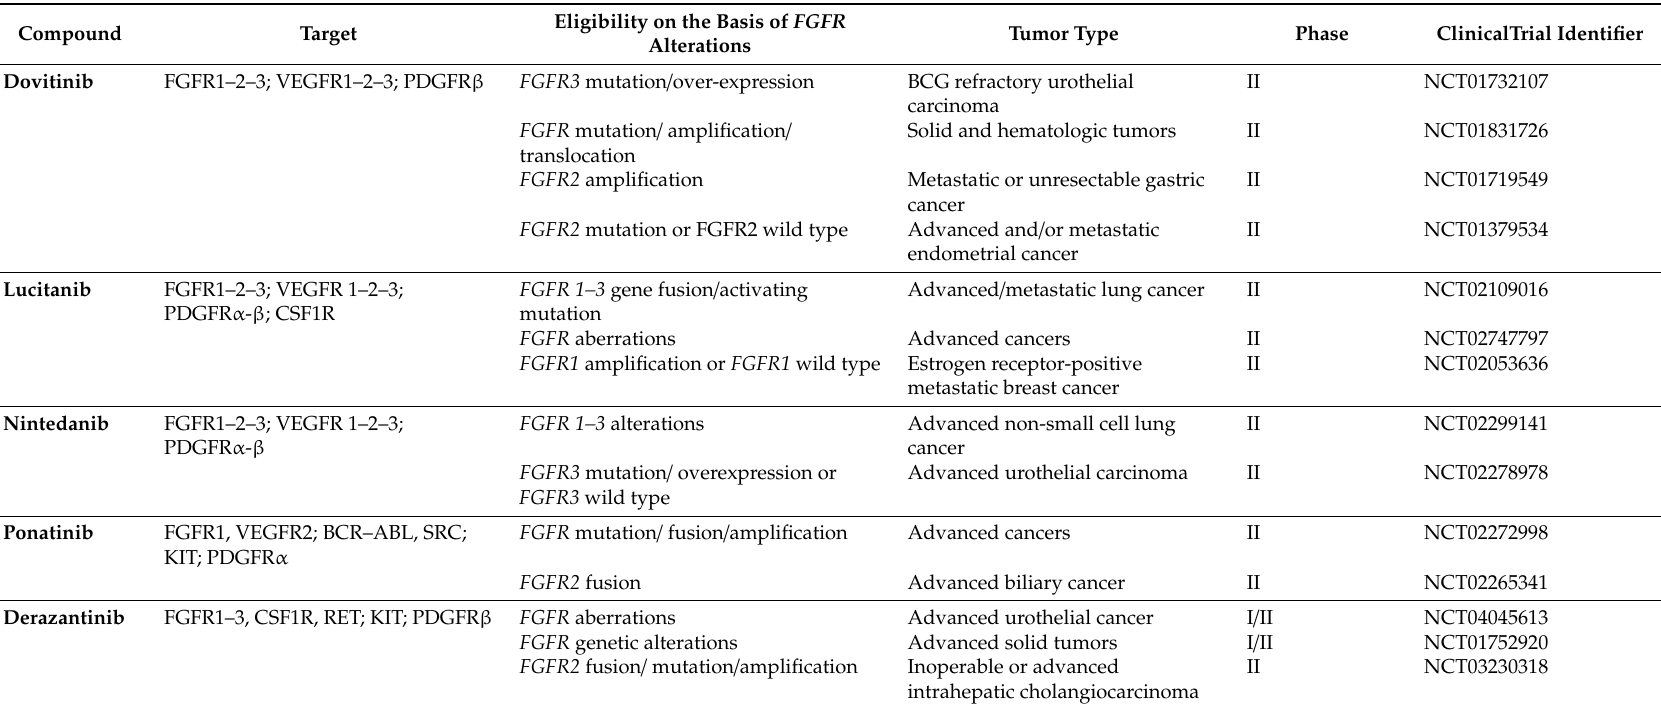
Table 3. Clinical trials of non-selective FGFR inhibitors in patients with solid tumors and FGFR genetic